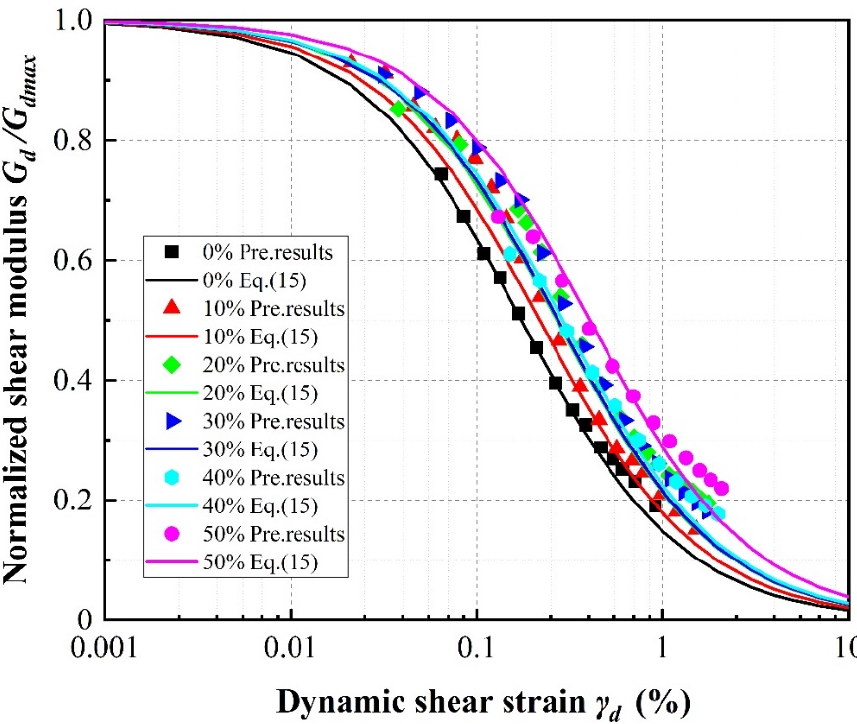
Figure 21. Normalized shear modulus versus shear strain for SRP2 under 150 kPa confining pressure according to rubber volume content.